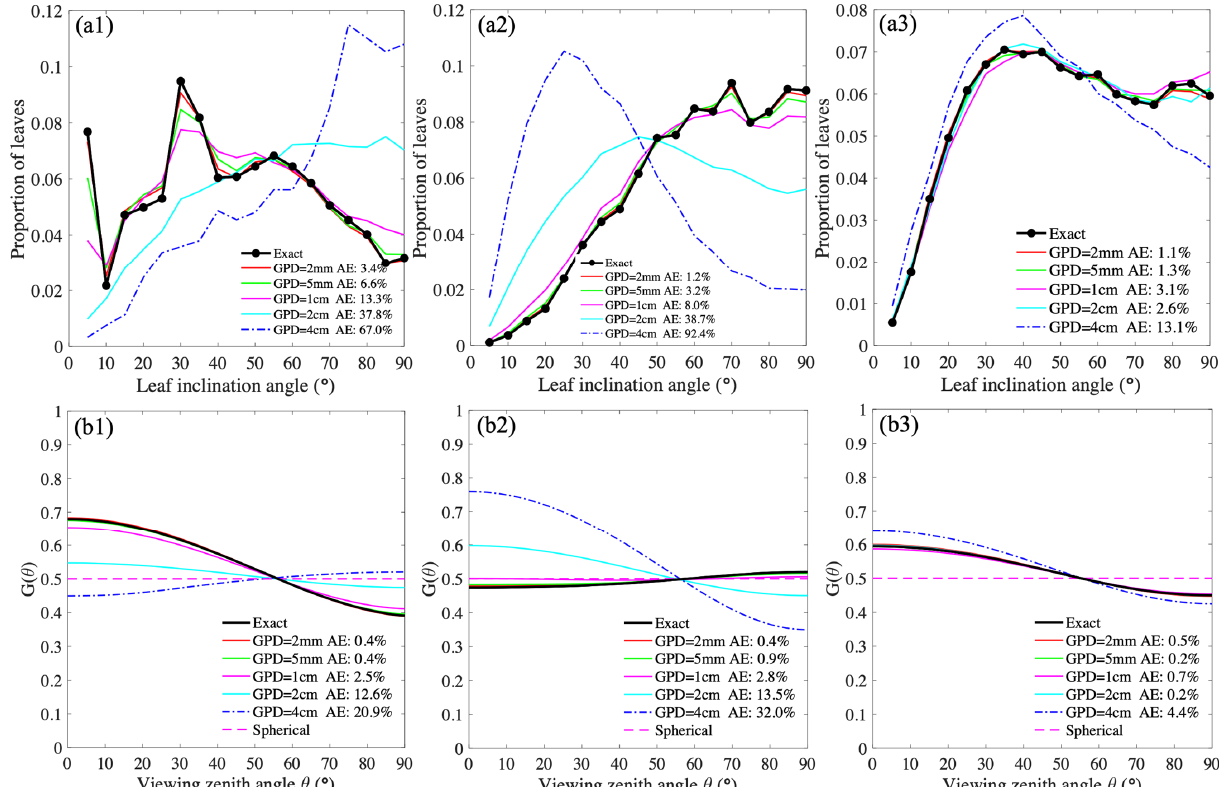
Figure 4. The estimated leaf angle distributions (LADs) ( a1 )–( a3 ) for Tree1, Tree2, and Tree3, respectively) and G-functions ( b1 )–( b3 ) for Tree1, Tree2, and Tree3, respectively) for the three tree models computed from the complete point clouds (CPCs) with different grid point distances (GPDs) (2 mm, 5 mm, 1 cm, 2 cm, and 4 cm): the “Exact” curves in black are the true LADs and G-functions; AE denotes percentage of the overall deviation between the estimated value and the true value, and the corresponding calculations are given in Equation (4) and Equation (5).